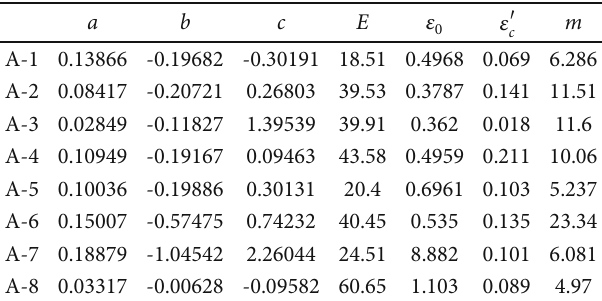
Table 2: Parameters of Duncan-Chang